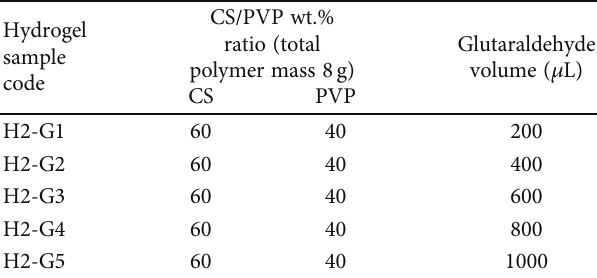
Table 2: Hydrogel H2 modi fi ed by varying the concentration of glutaraldehyde. Hydrogel